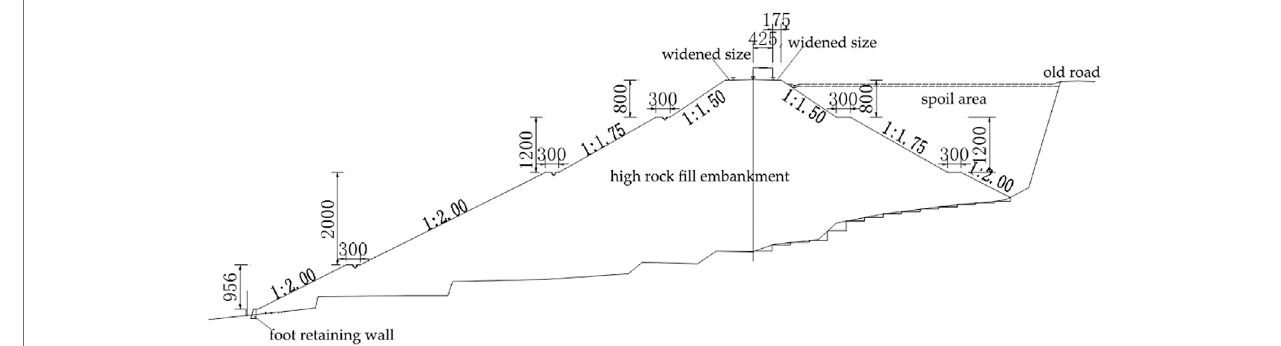
FIGURE 1 | Practical K21 + 460 sectional view (mm).